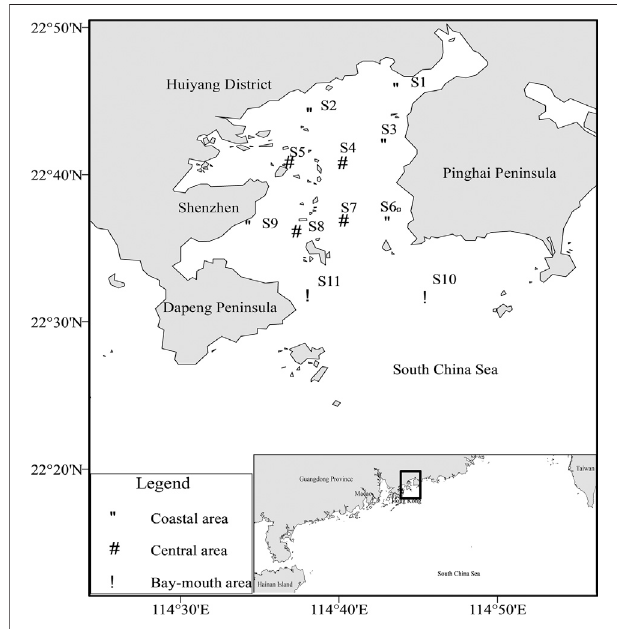
FIGURE 1 | Map of sampling stations in Daya